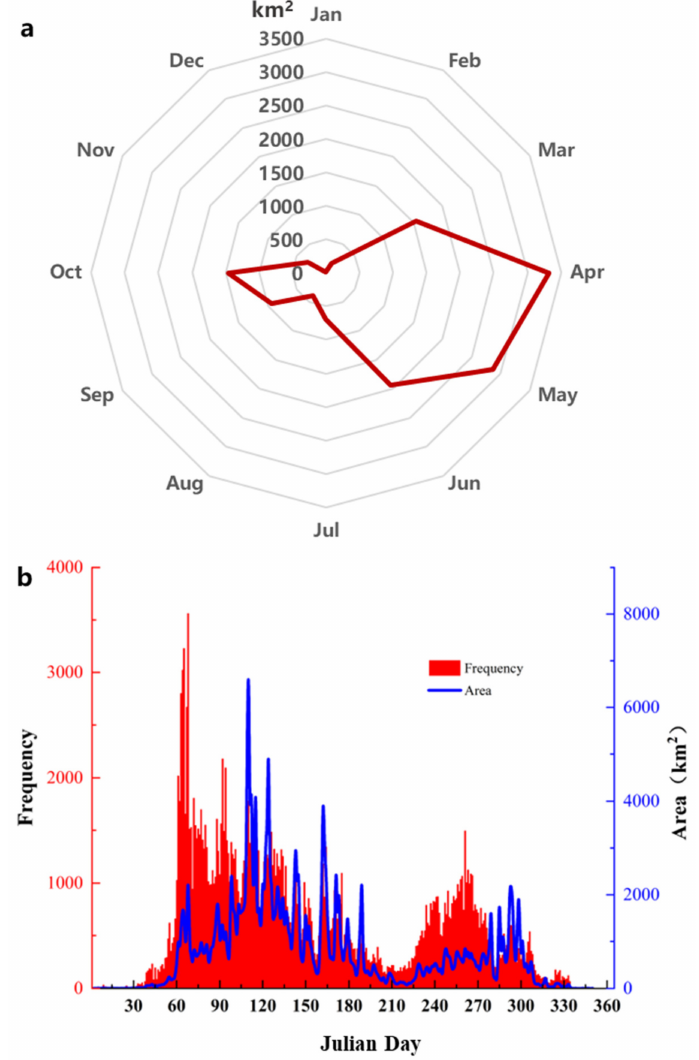
Figure 4. Fire temporal pattern in the Mongolian Plateau (MP) from 2001 to 2021. ( a ), monthly pattern; ( b ), daily